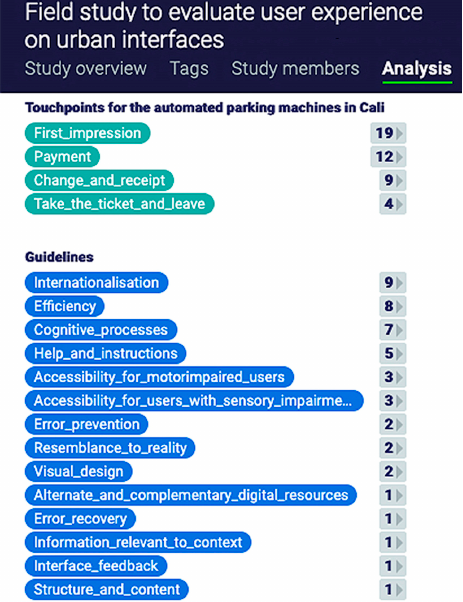
Figure 16. Screenshot of analysis of the automated parking machines in Cali performed in Reframer showing the frequency of field notes for each guideline (in blue) and touchpoint (in green).